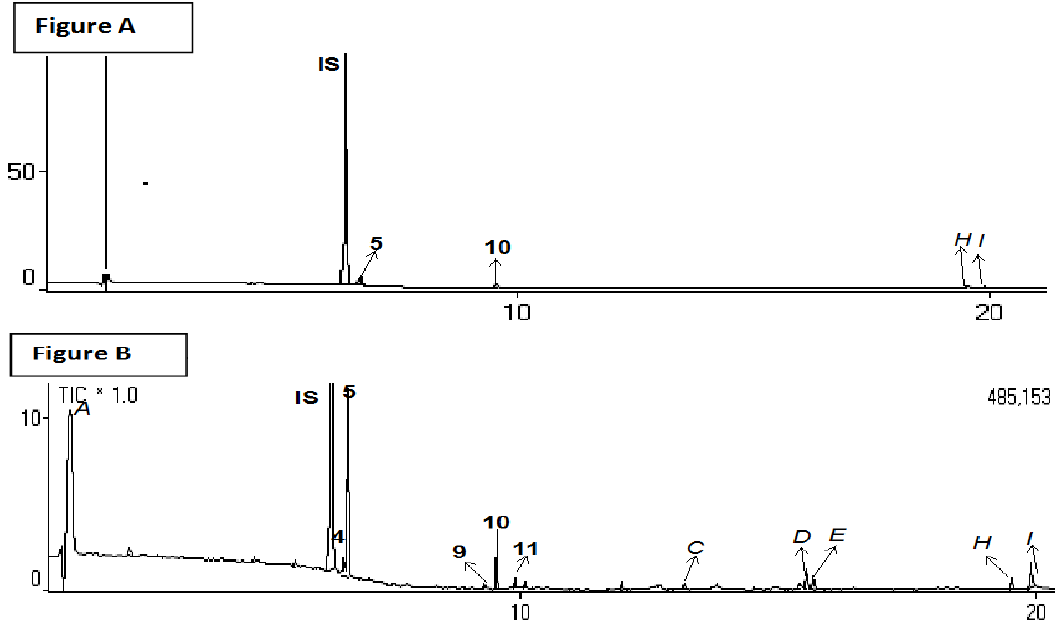
Figure 1. Total ion chromatogram of essential oil compounds in blood plasma of mice after inhaling essential oil of cajuput leaves. Figure A shows the chromatogram of essential compound after ½h inhalation, while figure B shows the chromatogram of essential comp